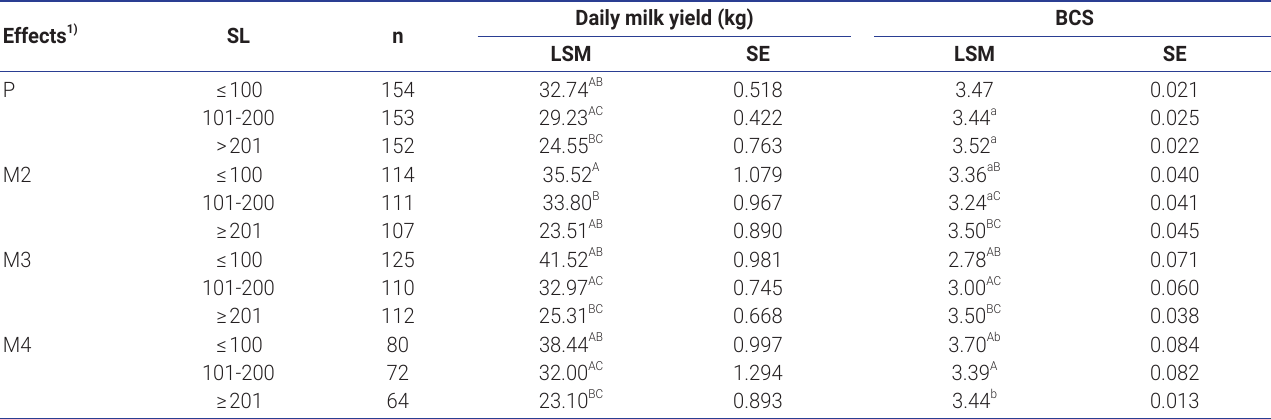
Table 2. The effect of lactation stage on the milk performance and body condition scoring (BCS) of cows Effects